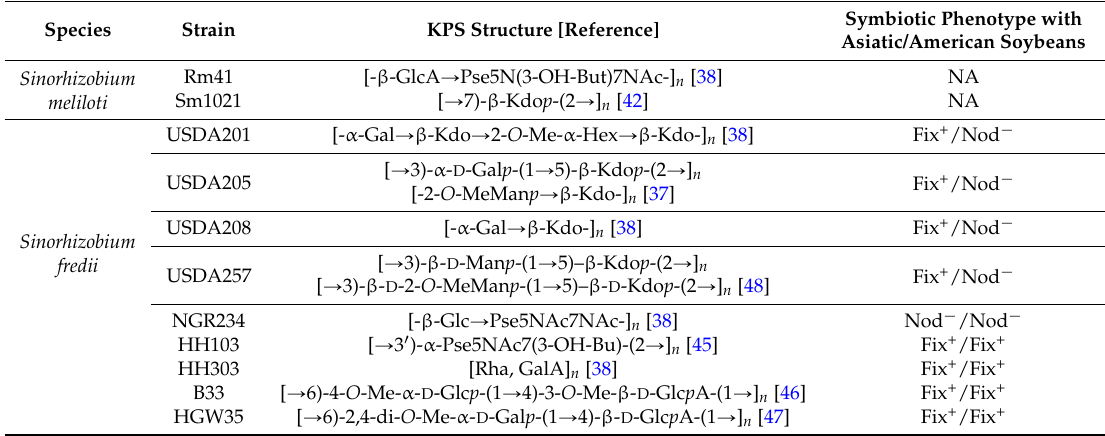
Table 1. KPS structures of